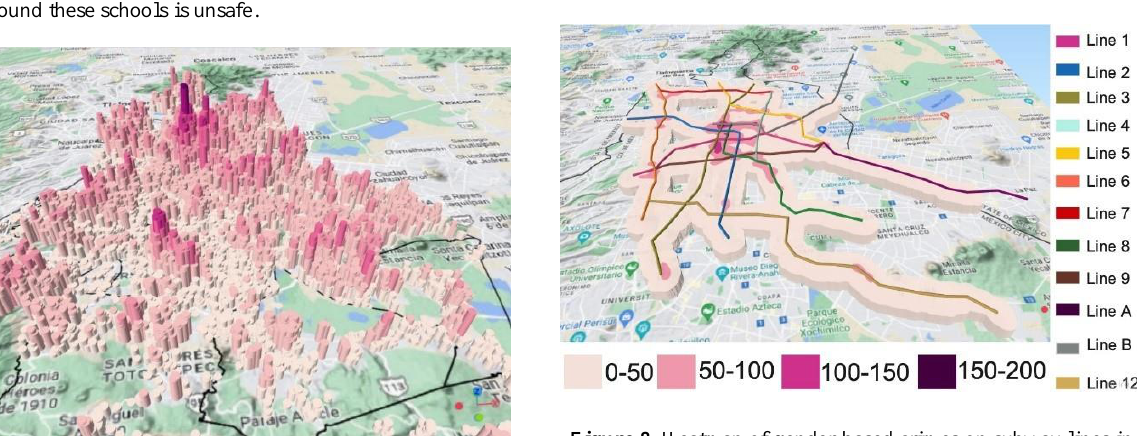
Figure 8. Heatmap of gender-based crimes on subway lines in